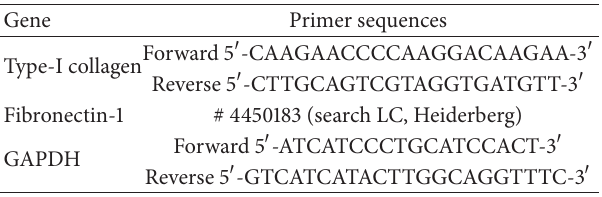
Table 1: Sequences of PCR